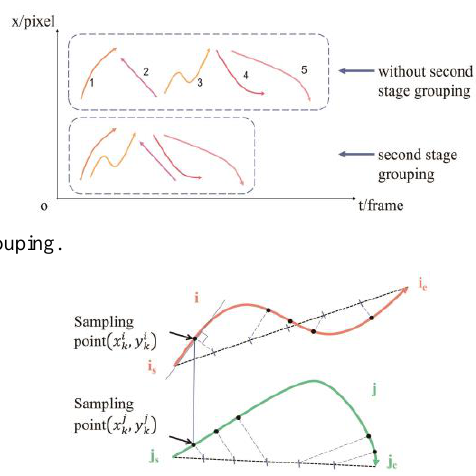
Fig. 4. Equidistant nearest neighbor sampling